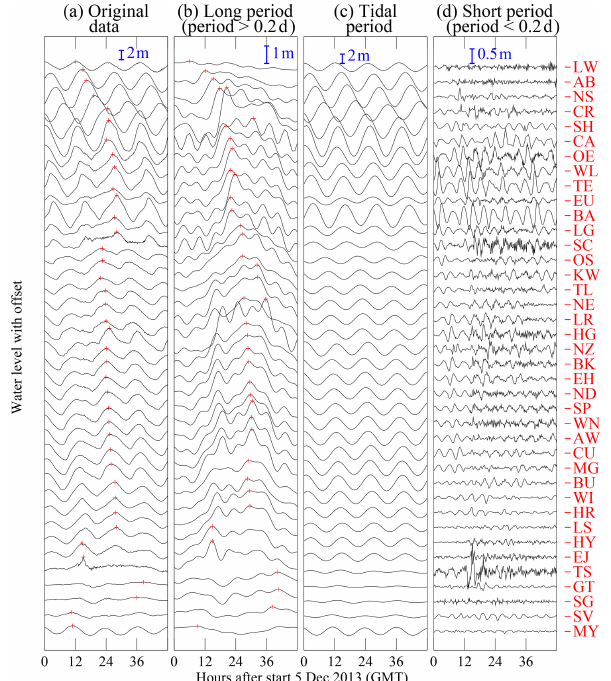
Figure 4. Time series of the (a) original water level data, and recon- structions of the (b) long period, (c) diurnal plus semi-diurnal tide, and (d) short period components of the original time series. For presentation clarity, the panels show a subset of half of the number of stations that were analysed. The station identifications are given by two letter codes along right hand side of the last panel, and the stations have been vertically offset according to counter-clockwise location around the North Sea starting from Lerwick in Scotland at the top and ending with Maløy on the Norwegian coast at the bottom.